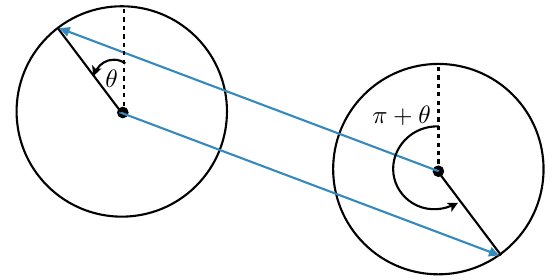
Figure 6. The influence coefficient calculations between a pair of VAWTs will always have paired locations that have exactly equal and opposite distance vectors if the two VAWTs are of equal radius. These two evaluation locations result in the exact same influence coefficients, reducing the amount of calculations that must be per- formed.